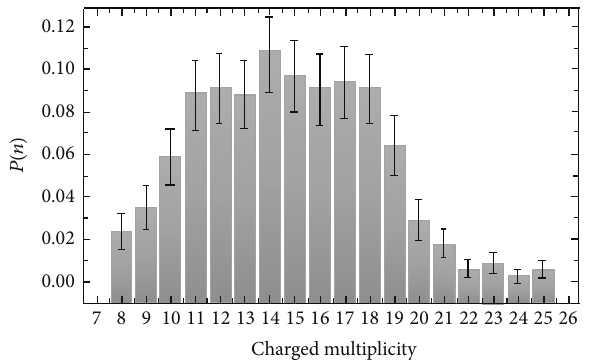
Figure 3: Measured charged particles multiplicity based on KNO